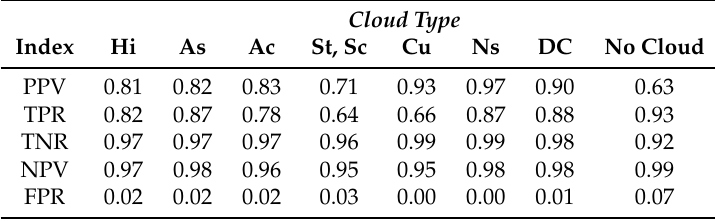
Table 4. Results for statistical evaluation of